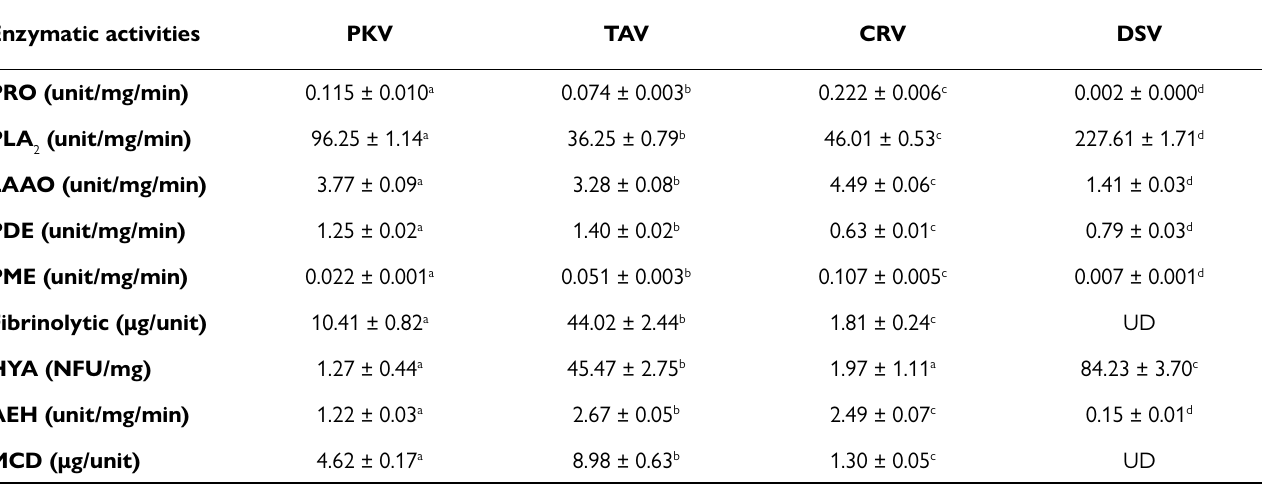
a,b,c,d Means within a row with different superscripts between groups of each measurement differ significantly (p < 0.05). PRO: protease activity; PLA phospholipase A activity; LAAO: L-amino acid oxidase activity; PDE: phosphodiesterase activity; PME: phosphomonoesterase activity; MCD: minimum coagulant 2 dose; AEH: arginine ester hydrolase activity; HYA: hyaluronidase activity; UD: undetectable; PKV: Protobothrops kelomohy venom; DSV: Daboia siamensis venom ; TAV: Trimeresurus albolabris venom; CRV: Calloselasma rhodostoma